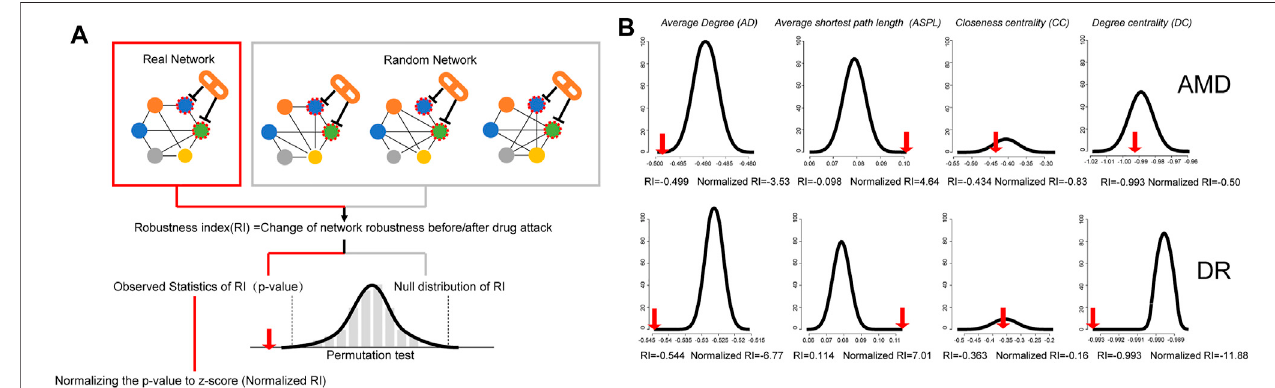
FIGURE 1 | Schematic diagram of quantitative algorithm of the drug attack on network robustness (A) and permutation test of HXMM attack to AMD and DR network (B) . (A) Simulation of the disease network and the impact of drug attack on the robustness of the network. The schematic diagram simulates the calculation process of the impact of drug attack on the robustness of the disease network. In the same disease network, deleting different nodes will cause different changes in the networkstructure and robustness. Changeofnetwork topologicalfeaturesafter drugattack wasused asrobustnessindex (RI)ofnetworks.Thenulldistributionof RIof100randomnetworkswasgeneratedtomaintainthesameedgenumberofthetruenetworkandrandomizeinteractionsbetweennodes.Thedottedareaindicated the 95% con fi dence interval via the Permutation test. Compared with the null distribution, the statistical signi fi cance of RI of true network can be calculated and normalized RI can be corrected. We can normalize the p -value (observed statistics of RI) to z-score, which is (n-Normalized RI). By constructing a random network, simulatingtheoveralldistribution oftheimpactofdeletednodesontherobustnessoftherandomnetwork(permutationtest),investigatingthepositionofthedrugonthe realnetworkdisturbance intheoveralldistribution, calculatingthecorrecteddisturbance rate,and theintensityofdrugdisturbance onthereal networkcanbeevaluated objectively. (B) Permutationtest ofHXMM RIsofrealnetworkwereshown. Toevaluate thedrugdisturbanceon thenetworkfrom fourtopologicalfeatures,including the AD, ASPL, CC, and BC. The red arrow pointed to the RI under the real network. The null distribution of RI of drug attack on the random network was shown as normal distributioncurve.InAMDnetwork,thenormalizedRIofAD,ASPL,DCandCCwere-3.53,4.64,-0.83and0.5,thecorresponding fi guresofDRwere-6.77,7.01,-0.16.- 11.88.